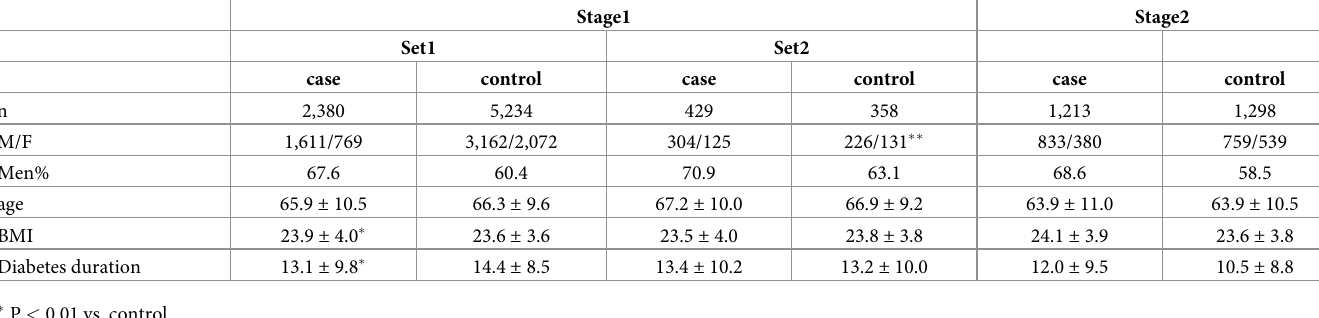
Table 1. Clinical characteristics of